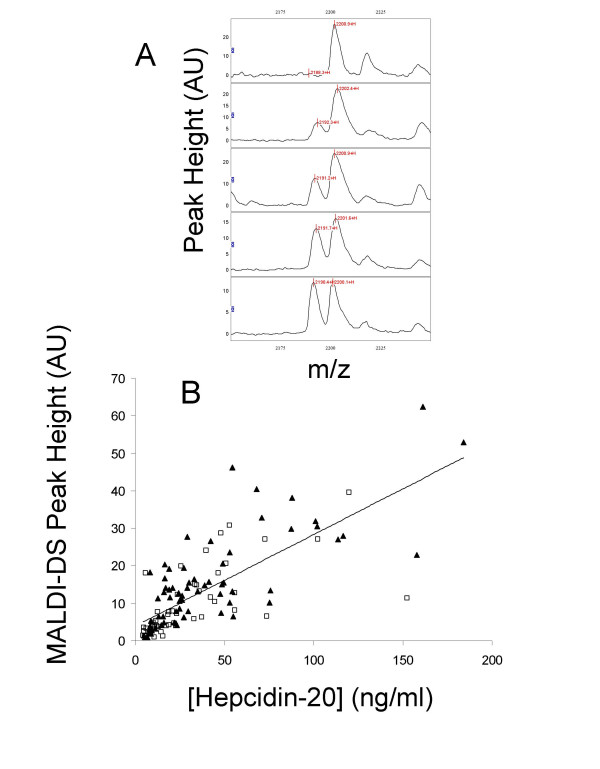
Determination of urinary hepcidin-20 by comparison to stable isotope labelled hepcidin-20. All urine samples were diluted to 20 μg protein/ml and spiked with labelled hepcidin-20 prior to desalting on C8 beads and MALDI mass spectrometry. Figure 9a shows spectra of 5 urines with increasing levels of endogenous hepcidin-20 (m/z 2192) spiked with 80 ng/ml labelled hepcidin-20 (m/z 2202). Figure 9b shows the correlation between the hepcidin-20 concentrations determined from spiked experiments and the peak intensities in the original MALDI-DS experiment. Non-cancer controls are indicated by solid triangles and cancer patients by open squares.